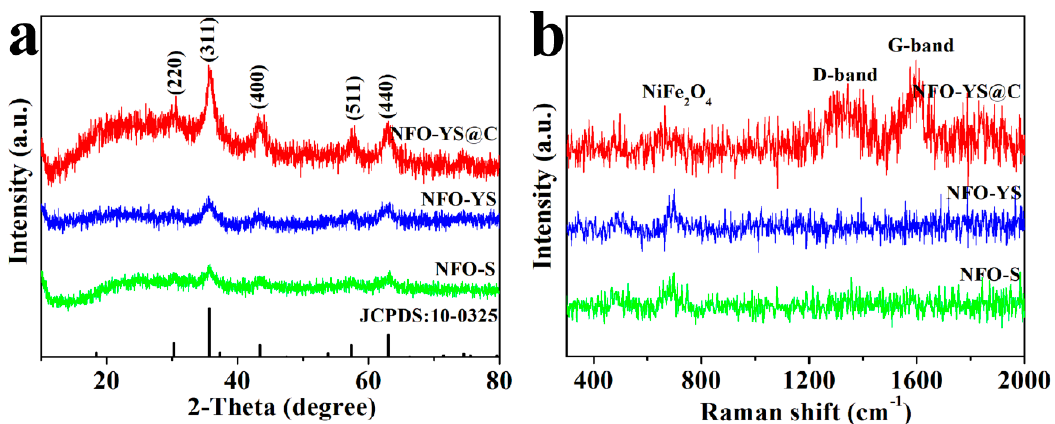
Figure 5. XRD patterns ( a ) and Raman spectra ( b ) of NFO-YS, NFO-S, and NFO-YS@C.